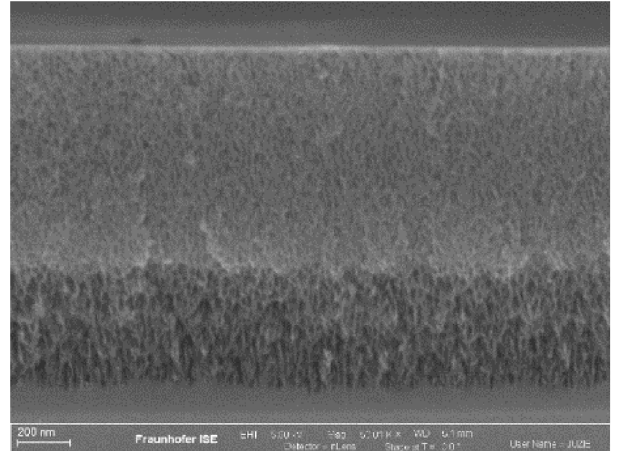
Fig. 5. SEM image of a silicon substrate with two porous layers. Layer 1 is the top layer with lower porosity and Layer 2 the one below that. The two layers as well as the surface and bulk material are visible distinguishable, which allows thickness evaluation based on these